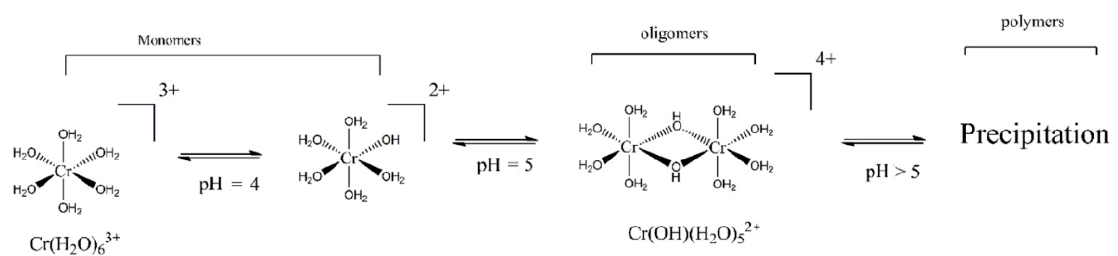
84+ by hydrolysis and polymerization of [Cr(H 2 (H 2 O)